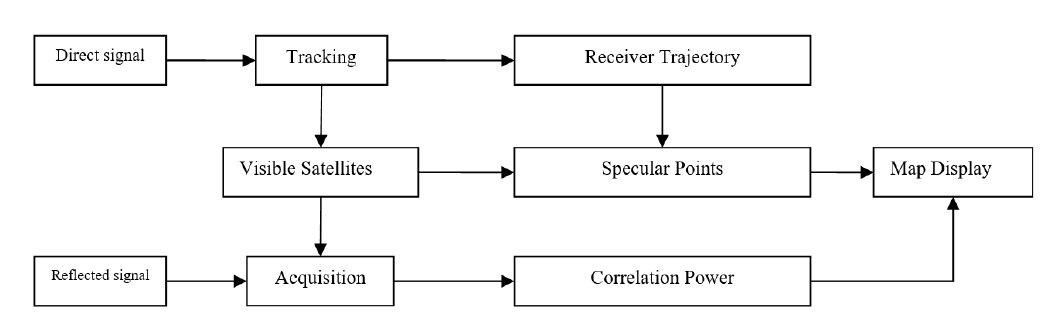
Figure 2. Block diagram of the post-processing